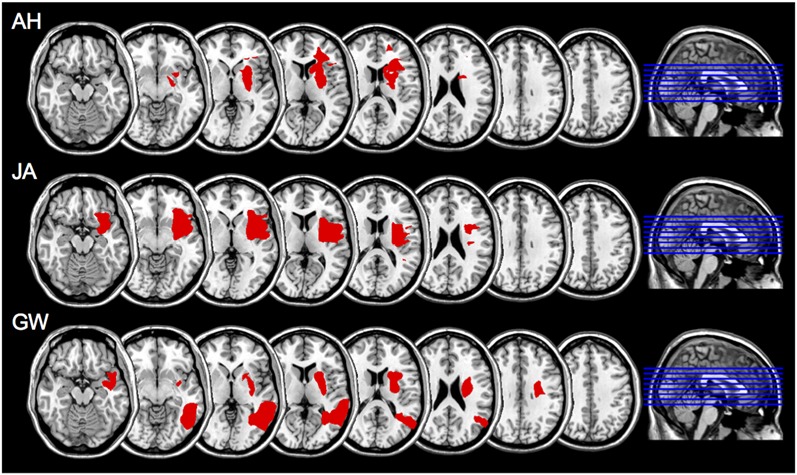
Scan slices for apraxic patients AH, JA, and GW; lesioned areas were applied to a template scan allowing clear visualization of the anatomical landmarks. The lesion area(s) are in red. Left is right as per neurological convention.